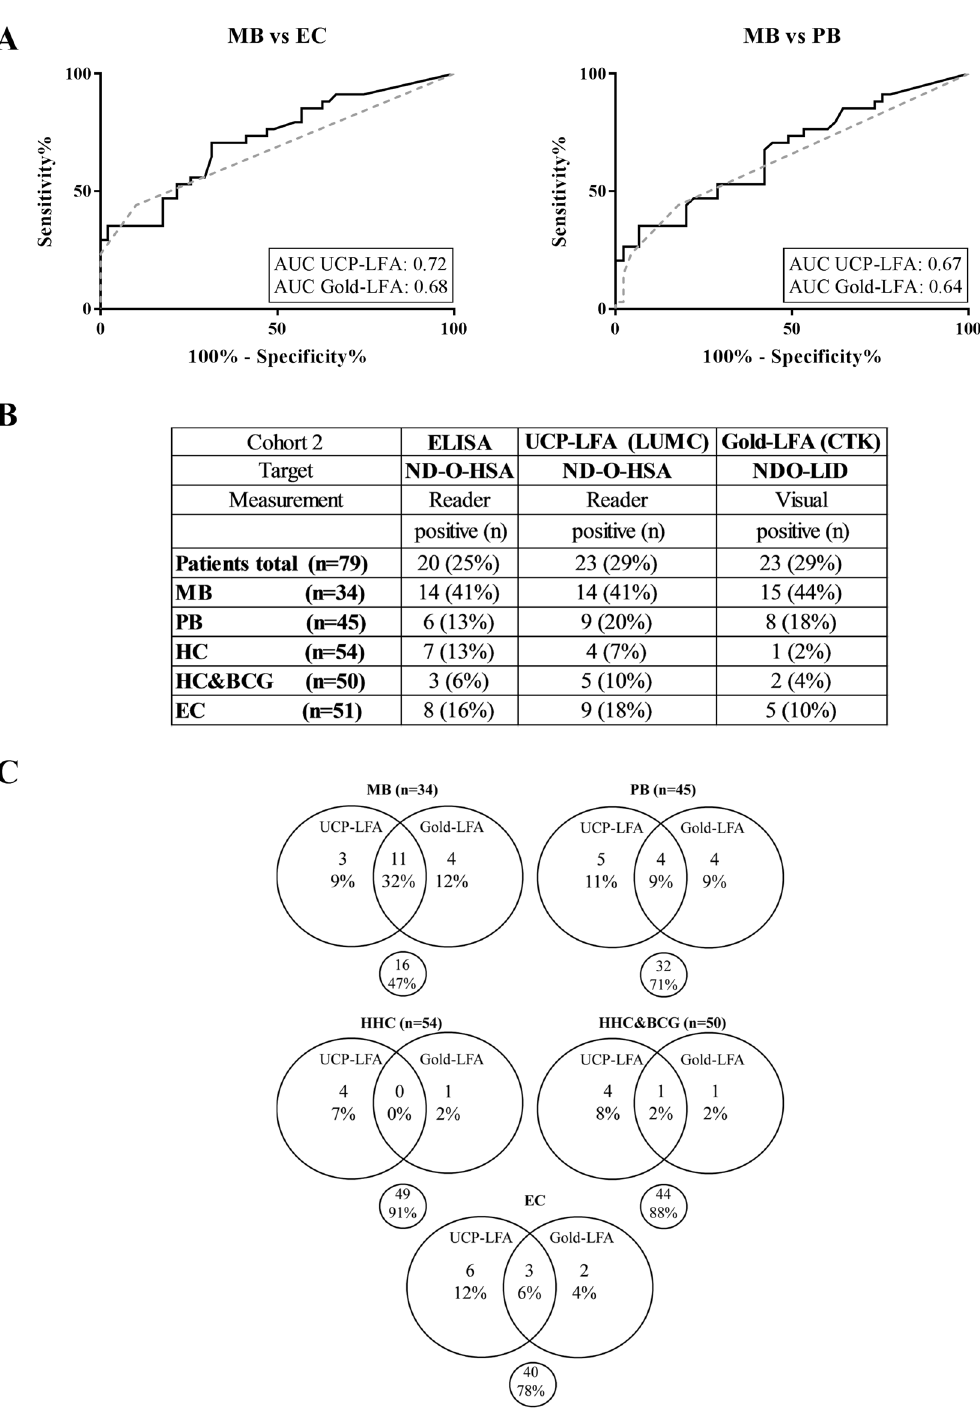
Figure 2. Test performance of UCP-LFA and Gold-LFA in a Bangladeshi cohort. Test performance was assessed using serum of 34 multibacillary (MB), 45 paucibacillary (PB) patients, 104 healthy household contacts (BGC-vaccinated [n = 50], non-vaccinated [n = 54]) and 51 endemic controls (EC). ( A ) Receiver operating characteristics (ROC) curves showing the distinction between MB patients and EC (left panel) and MB and PB patients (right panel) for the UCP-LFA (solid line) and Gold-LFA (dotted line). Areas under curve (AUCs) are displayed for both tests. ( B ) Number and percentage of positive individuals per test (ELISA, UCP-LFA, Gold-LFA) are shown for each test group. ( C ) Venn diagrams showing the concordance in positive individuals between UCP-LFA and Gold-LFA per test